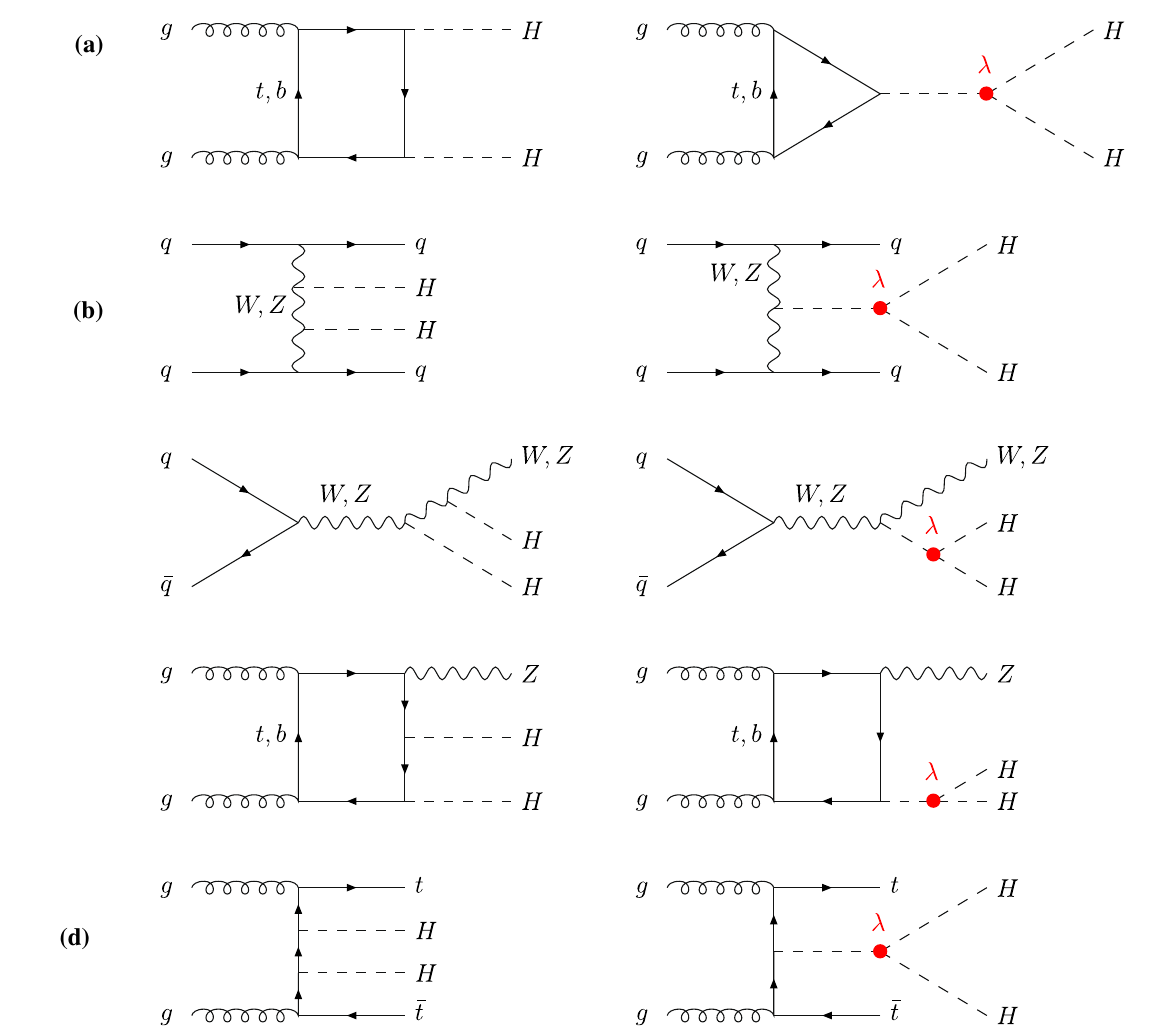
Fig. 1 Diagrams contributing to Higgs pair production: a gluon fusion, b vector-boson fusion, c double Higgs-strahlung and d double Higgs bremsstrahlung off top quarks. The trilinear Higgs self-coupling is marked in red Table 1 Signal cross sections ( σ , in fb) for HH production, including ggHH process, we added in quadrature also the dominant uncertainty the QCD corrections recommended by the LHC Higgs Cross Section induced by the finite m top corrections. The cross sections of W − HH, Working Group [48,74]. For each process, scale variations have been W + HH and ZHH processes have been summed together in a single symmetrized and added in quadrature to PDF+ α S uncertainties. For the VHH line and their uncertainties have been summed in quadrature Process σ (14 TeV)